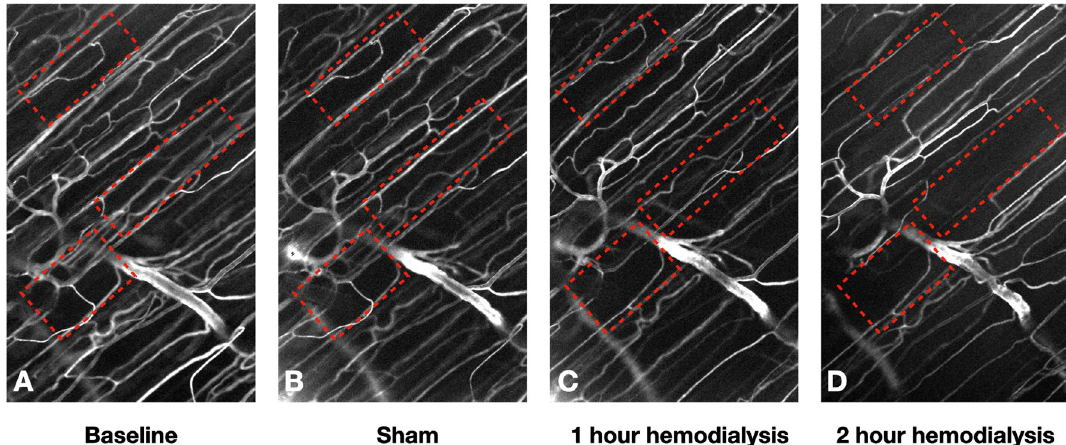
Figure 3. Tissue perfusion during hemodialysis. SAD images from an IVVM observation of the EDL microvasculature at different timepoints during HD (tissue area of 233 µm × 373 µm). ( A ): Baseline SAD image. ( B ): SAD image at 1 h sham procedure. ( C ): SAD image at 1 h hemodialysis procedure. ( D ): SAD image at 2 h hemodialysis (see the associated inverse videos in supplemental data: S3-Fig. 3A, S4-Fig. 3B, S5-Fig. 3C and S6- Fig. 3D) (image produced by B(GH) Janssen using Matlab 2020a, the Matworks Inc, Natrick, MA USA; https:// www. mathw orks. com).